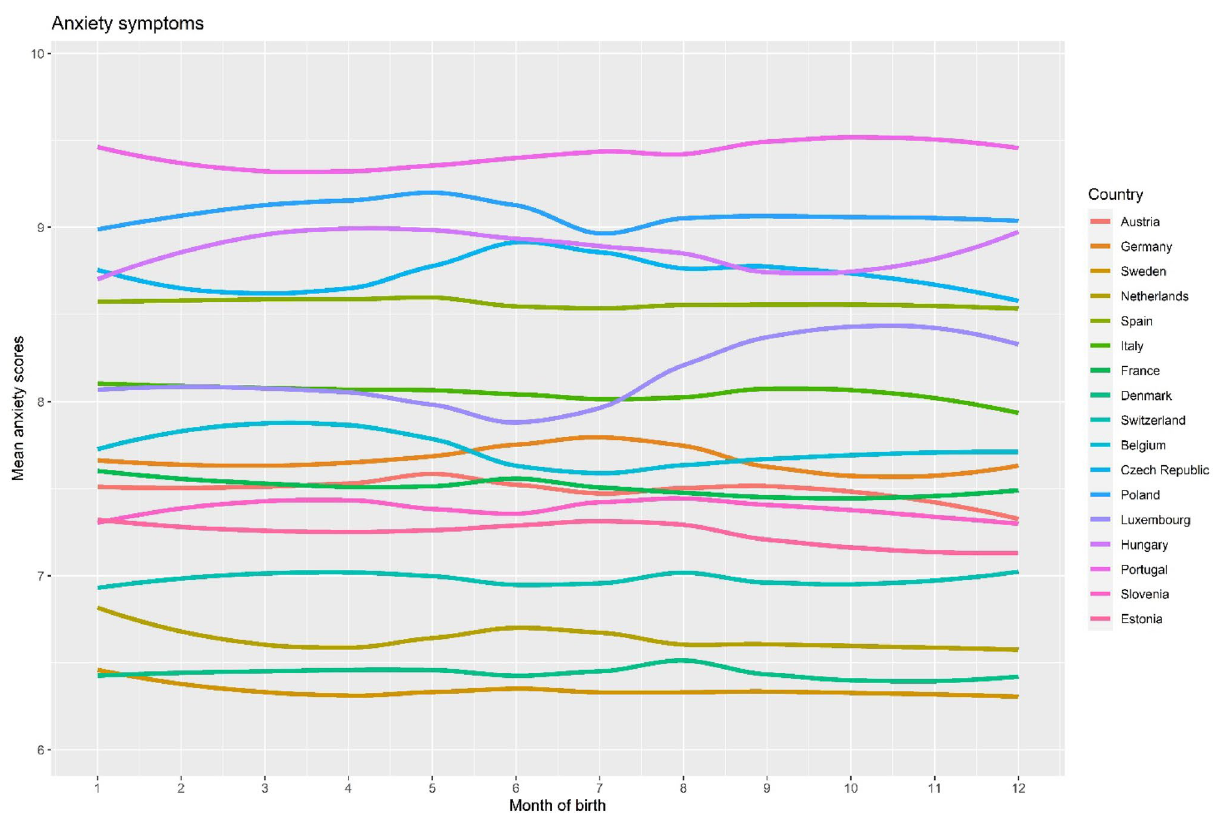
Figure 2. Mean anxiety symptoms by country and month of birth (anxiety scores ranged between 5 to 20; smoothing splines were fitted against mean scores).